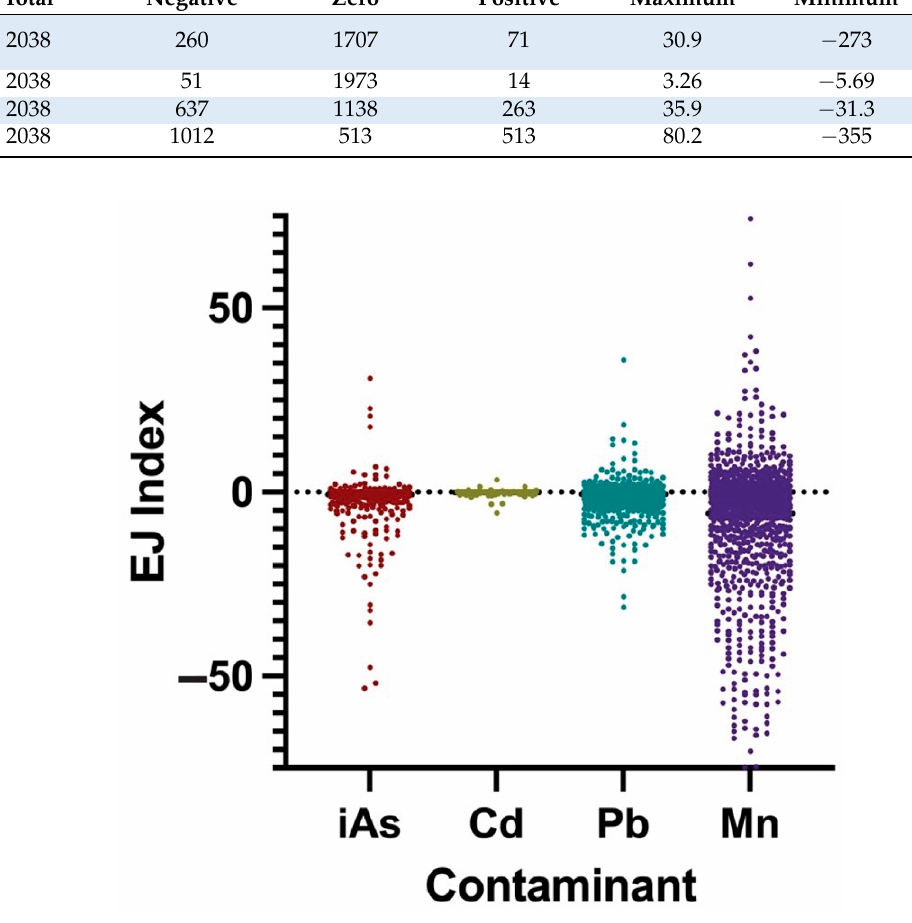
Figure 2. Distribution of EJIs for the four contaminants of interest: inorganic arsenic (iAs), cadmium (Cd), lead (Pb), and manganese (Mn). Positive EJIs represent contamination in disadvantaged areas.